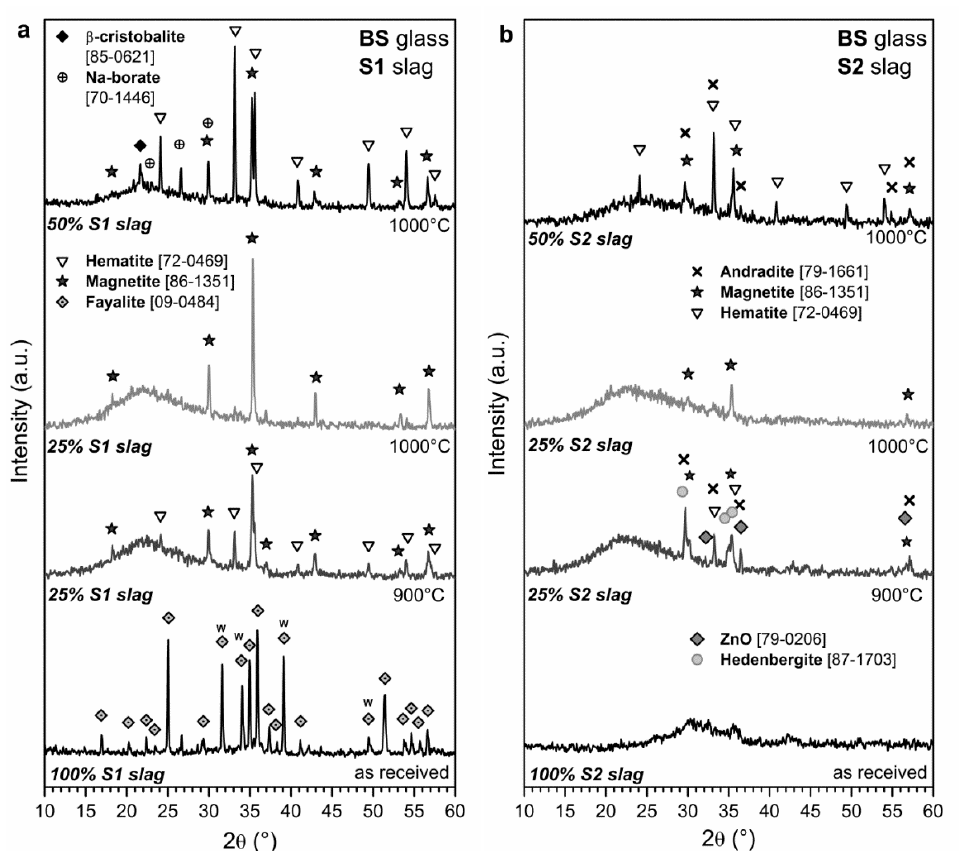
Figure 2. Crystalline phase evolution of glass/slag mixtures based on ( a ) S1 slag; ( b ) S2